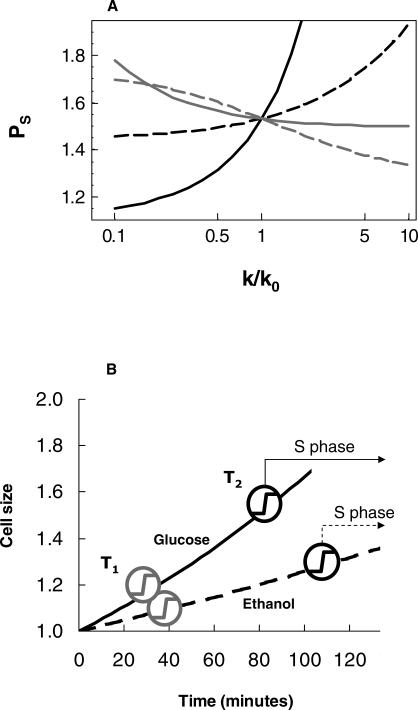
Regulation of the Critical Cell Size PS Necessary To Undergo G1/S Transition(A) Sensitivity analysis of PS. For each curve, an individual parameter has been varied from 0.1-fold to 10-fold. Black line: growth rate (k
growth, k
1, k
2 concomitantly); black dashed line: initial concentration of Far1 (far1cyt[0]); gray dashed line: initial concentration of Cln3 (cln3cyt[0]); gray line: binding value of Sic1 to the Cdk1-Clb5,6 complex (k
32).(B) Simulation of the G1/S transition in elutriated cells indicates how the setting of PS is achieved. Cells start at a volume of 1 and grow with different kinetics in glucose (solid line) and ethanol (dotted line). Overcoming of the first and second threshold, as identified by simulation, is shown by circled symbols (gray, first threshold; black, second threshold).